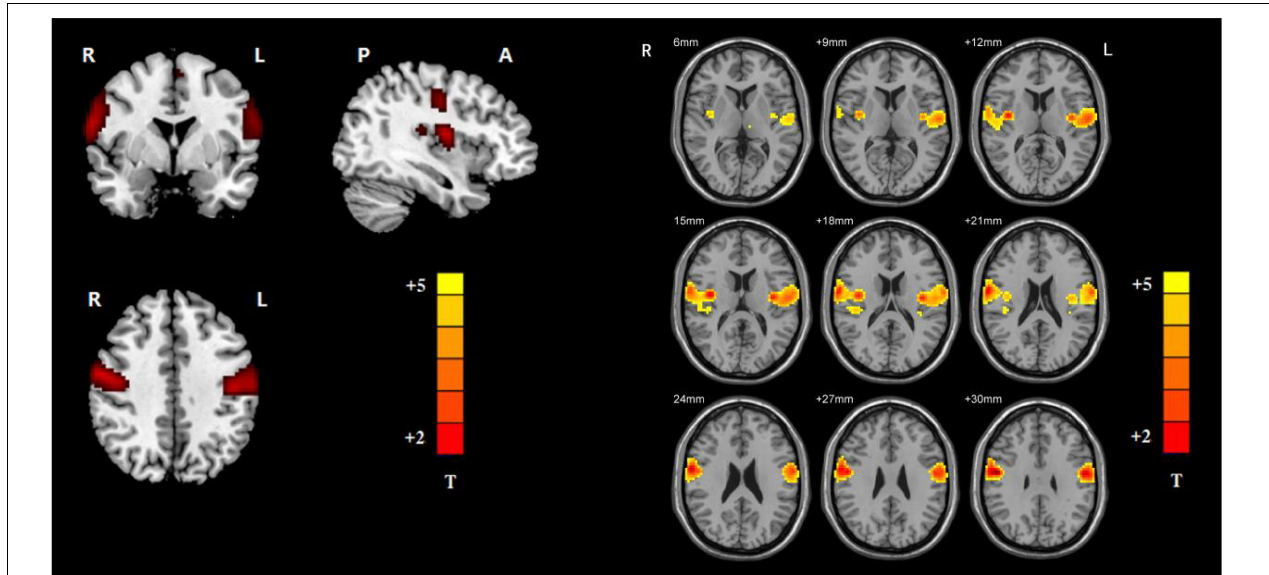
FIGURE 1 | Ventral somatomotor network (left: axial, coronal, and sagittal images of VSN; right: the detailed axial images of VSN. Based on group ICA with a threshold at z ≥ 5).